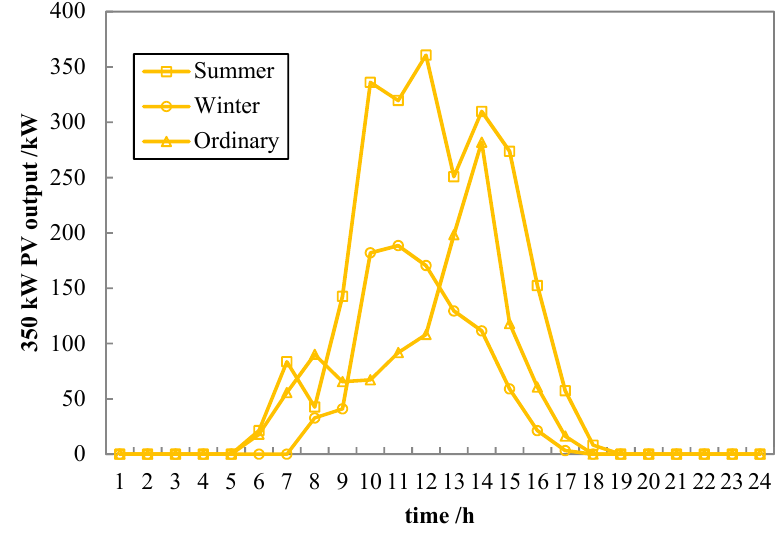
Figure 5. Typical daily 350-kW photovoltaic output curve. Table 1. Energy peak, normal, and valley prices.